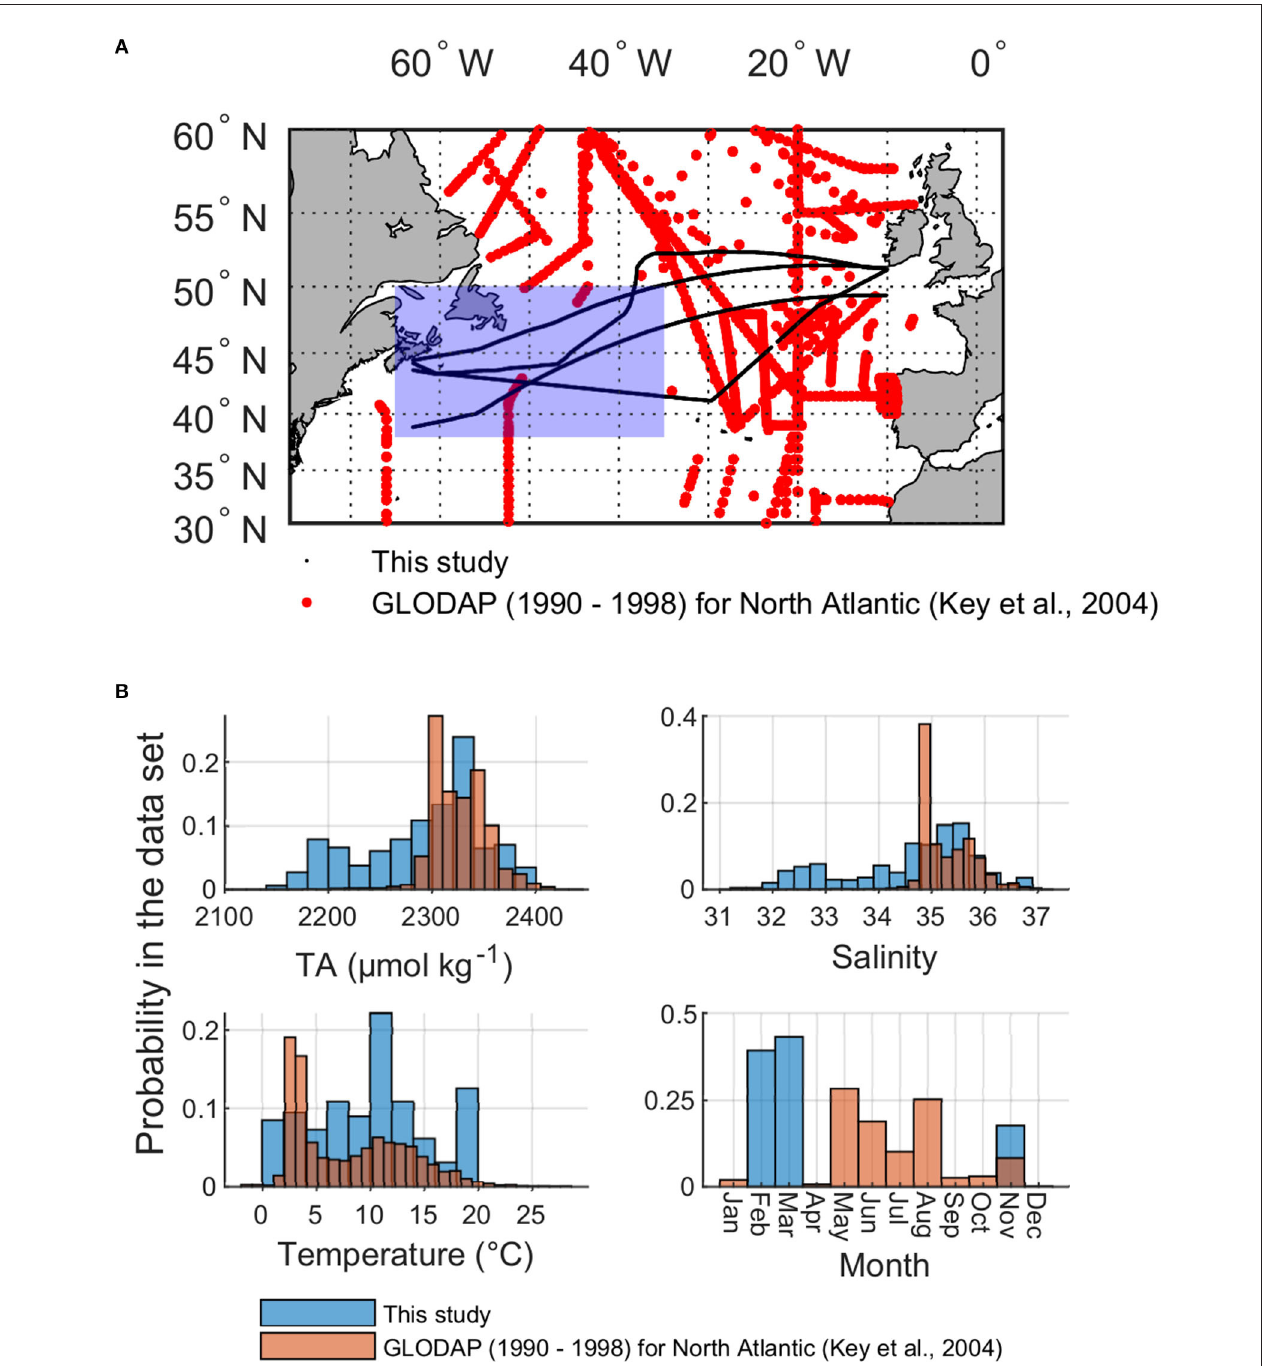
FIGURE 9 | (A) Spatial distribution of our measured data (black) and the GLODAP data set between 1990 and 1998 (red) for the North Atlantic ( 30 ◦ N - 60 ◦ N). The blue patch represents the area, which is underrepresented in the parameterization by Lee et al. (2006). (B) Histograms of observations of TA, salinity, temperature, and month of observation in the data set of this study (blue) and the GLODAP data set